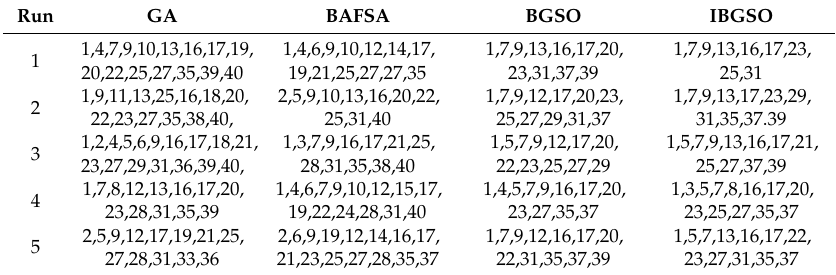
Table 4. Sensor selection results for subject 1 with five runs using the OPPORTUNITY dataset. Run